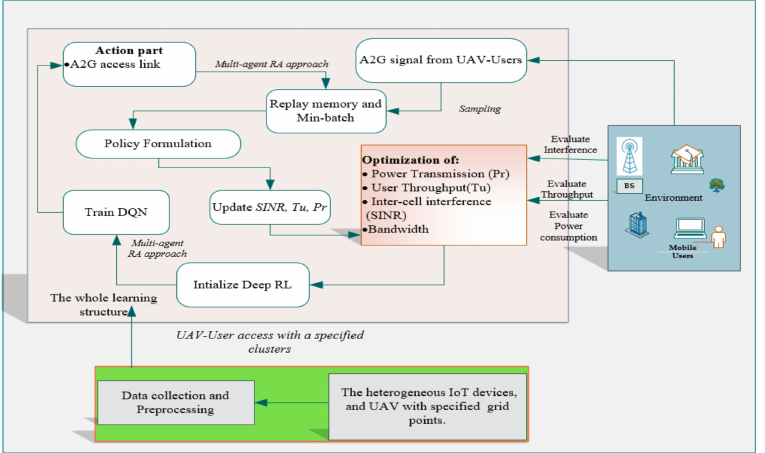
Figure 6. Proposed method architecture. A2G: air-to-ground; SINR: signal-to-interference-plus- noise